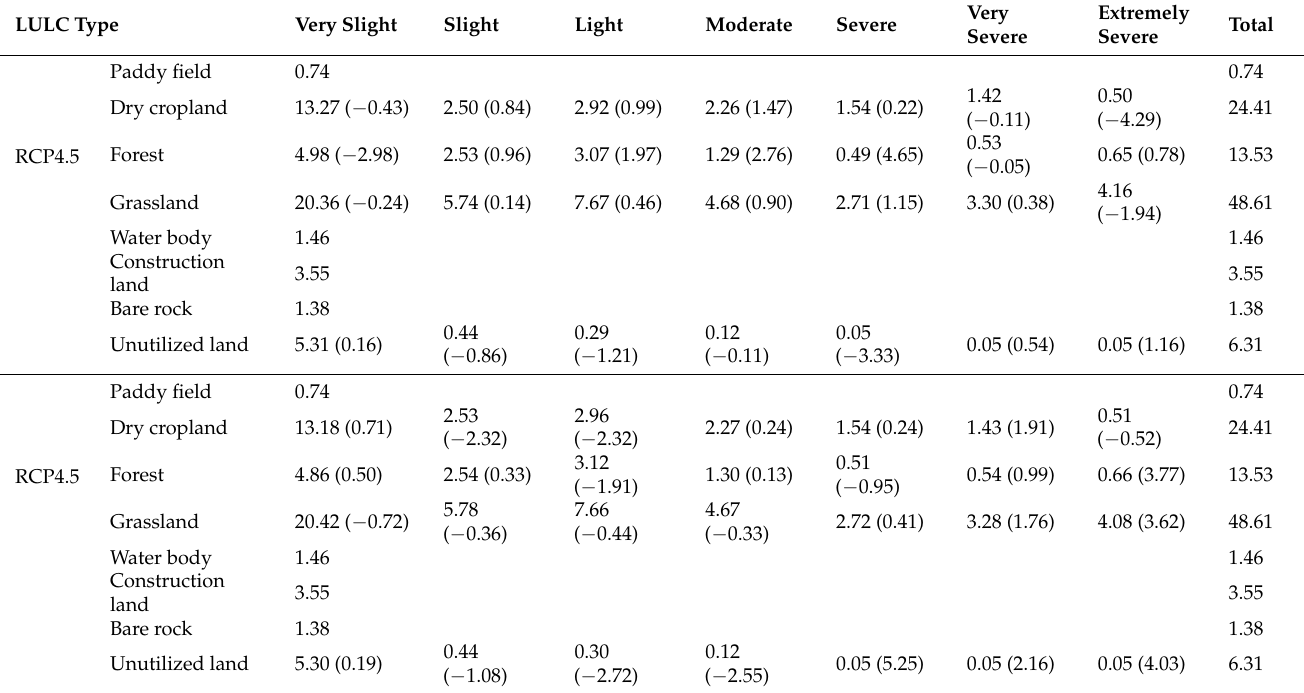
Table 5. Soil erosion area percentage (%) of different LULC